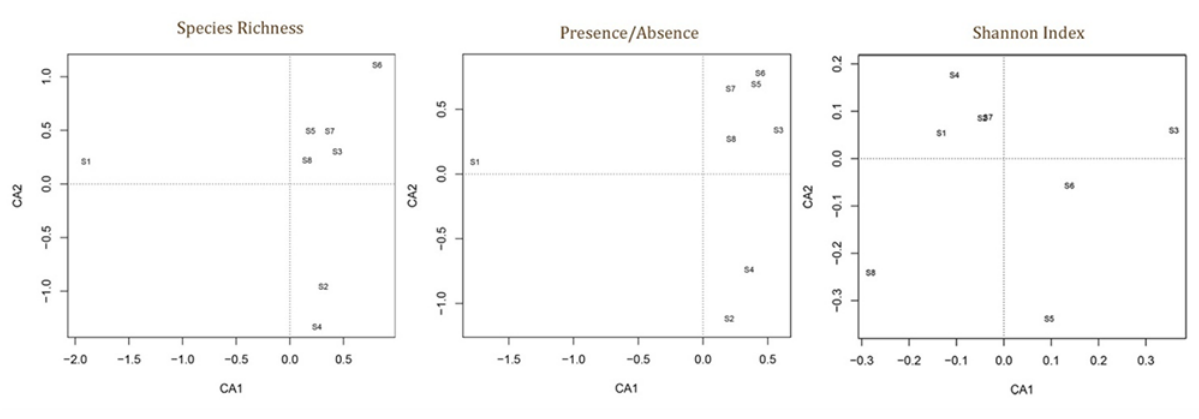
Figure 4 Graphical representation of correspondence analysis of the eight sites based on macrofungal species richness (on the le), presence/absence (middle) of species, and Shannon Index (right).